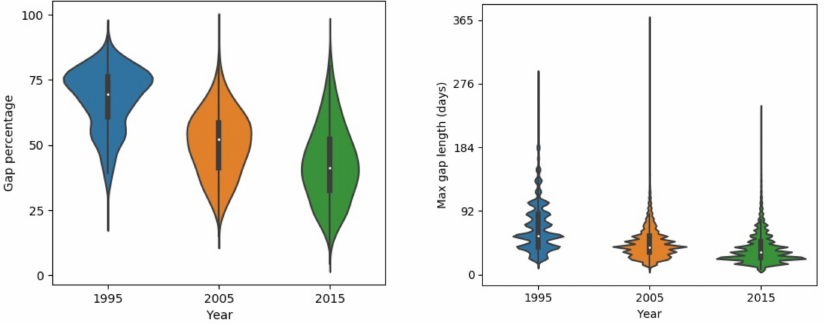
Figure 5. Gap patterns of raw Landsat NDVI time series in 1995, 2005, and 2015